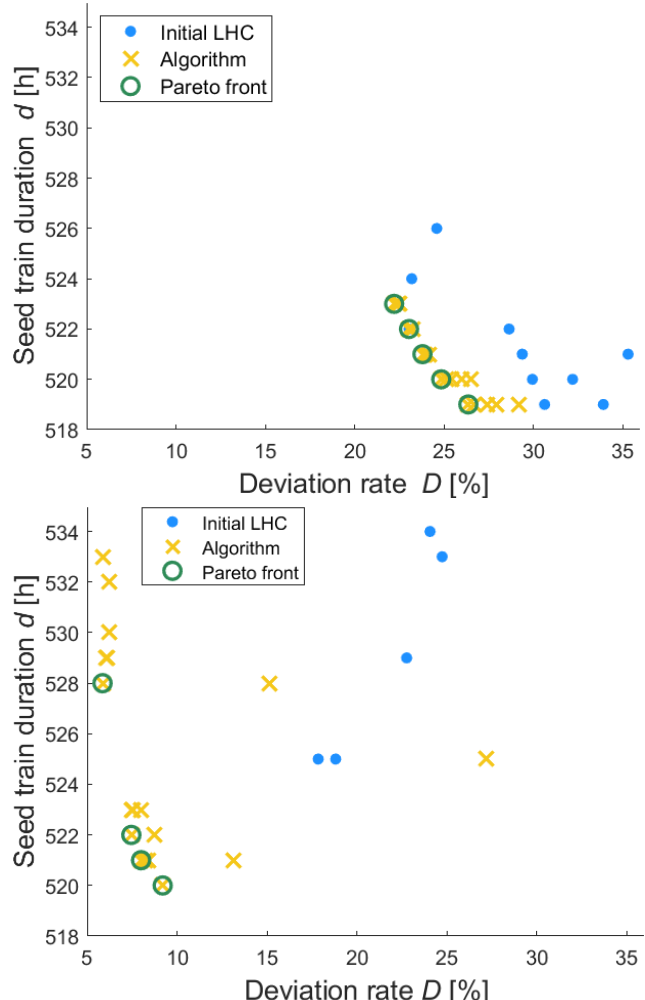
Figure 8. Algorithmically determined solutions and Pareto front regarding seed train duration and deviation rate for 3 resp. 4 shake flask scales on top resp. bottom. Blue dots show an initial Latin hypercube design (LHC); yellow crosses are the points proposed by the algorithm; green circles are Pareto optimal solutions (=Pareto